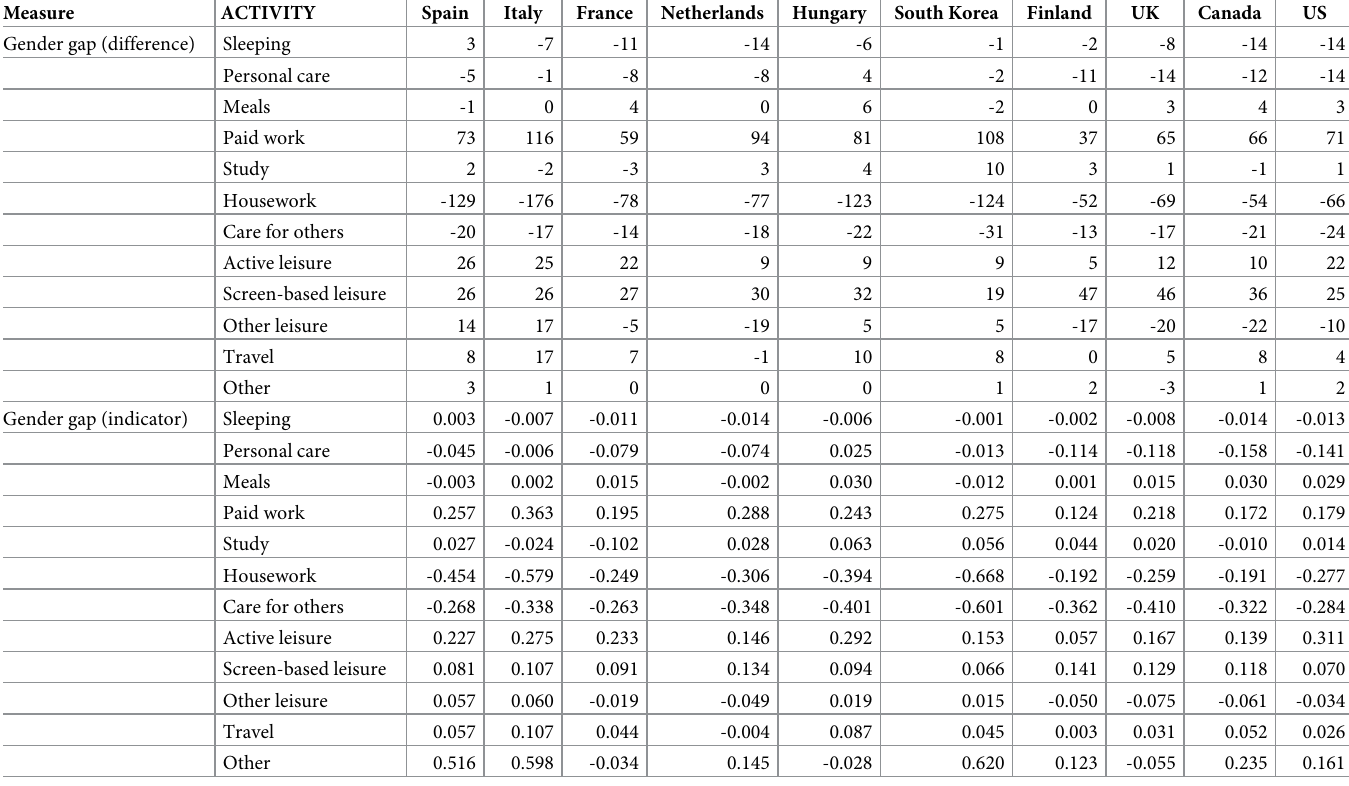
Table 2. Gender gap measure by activity and country. Measure Gender gap